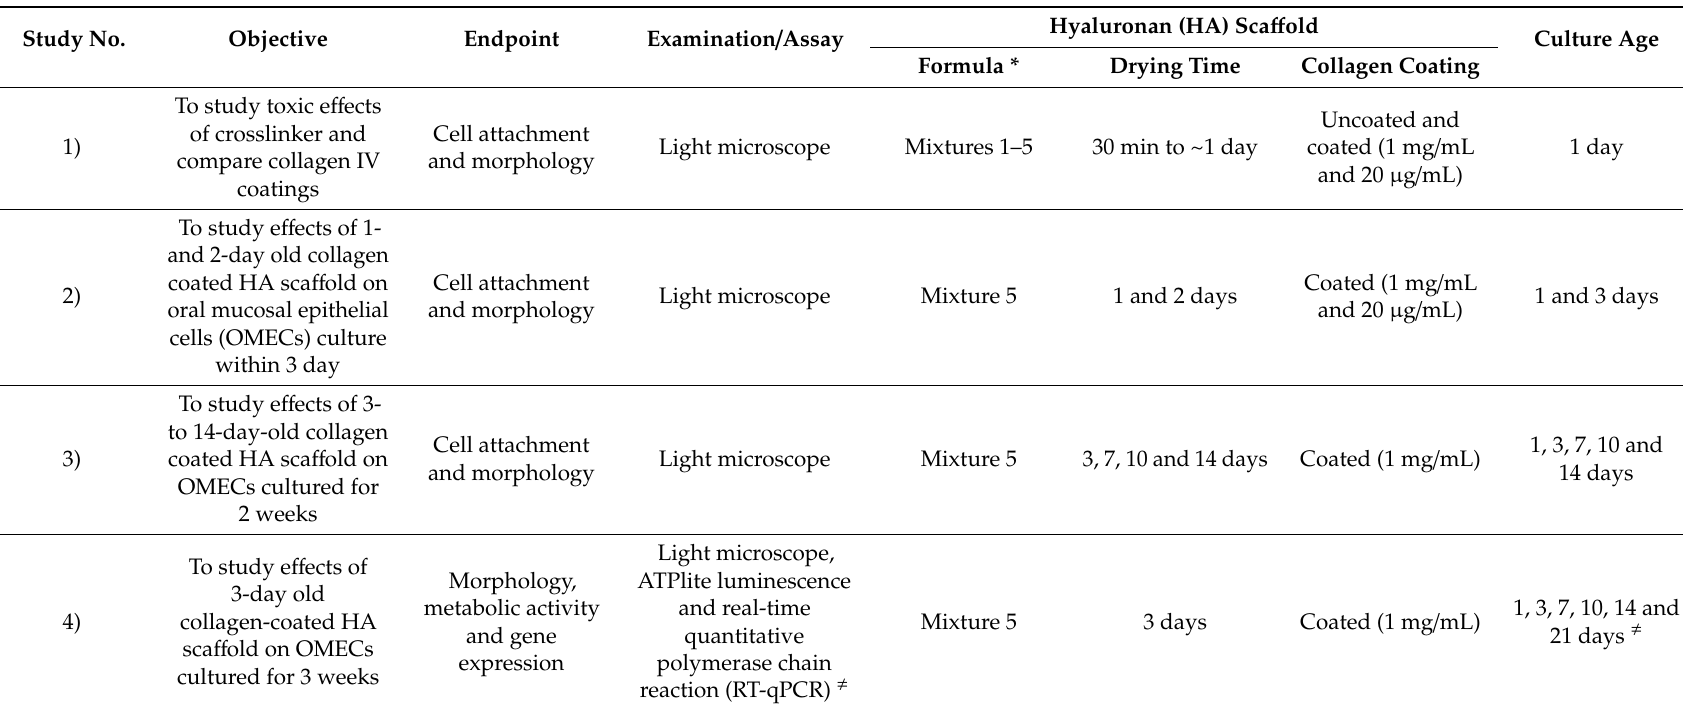
Table 2. Summary of